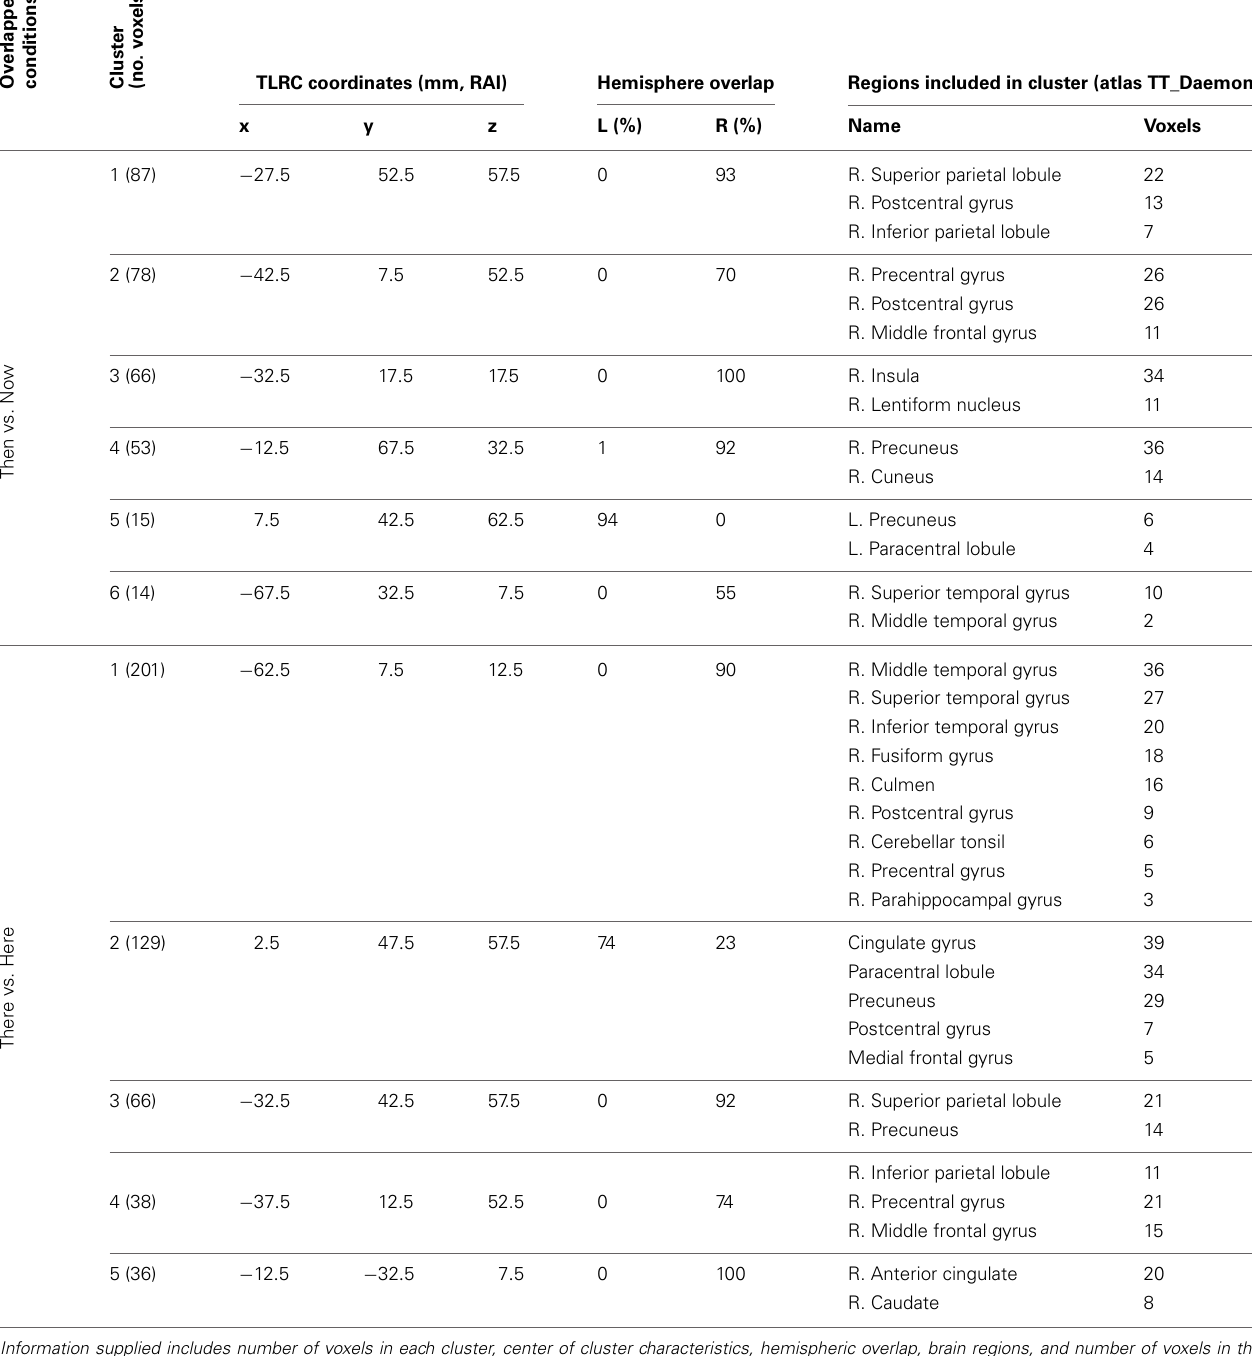
Table 4 | Beamforming solutions for contrasts Then vs. Now and There vs. Here in the theta (4–8Hz) frequency band. d e pp a l ve r O